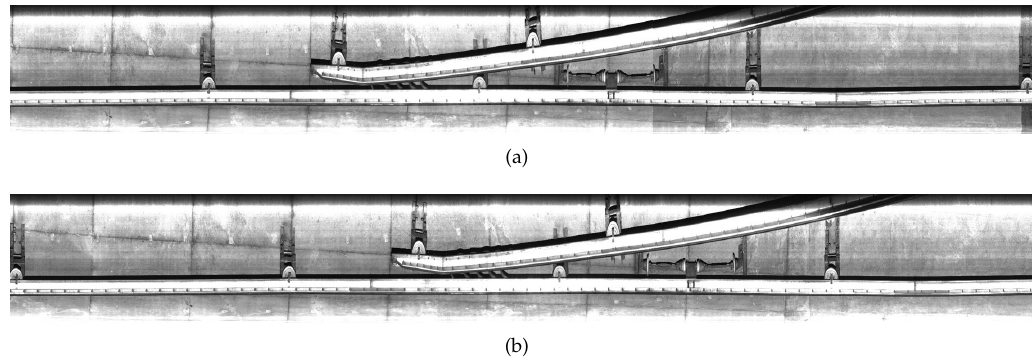
Figure 3. A pair of the images acquired at the same location but at different times. The image ( a ) was acquired before ( b